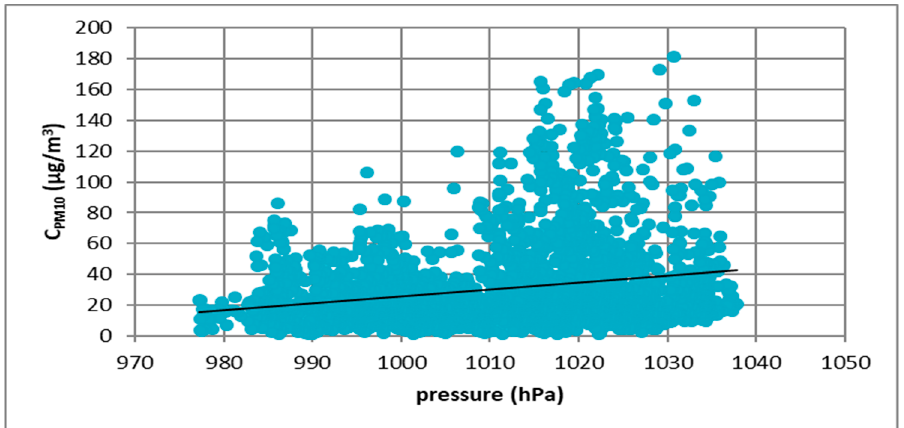
Figure 10. The e ff ect of atmospheric pressure on PM10 concentration in Gda´nsk in 2017.